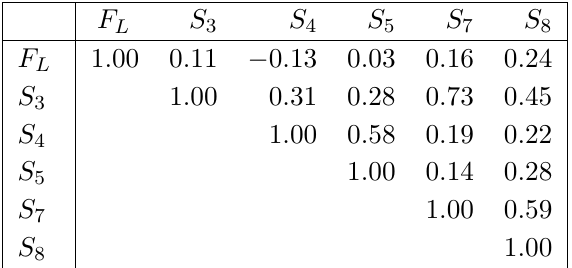
and S parameters obtained for q 2 2 L